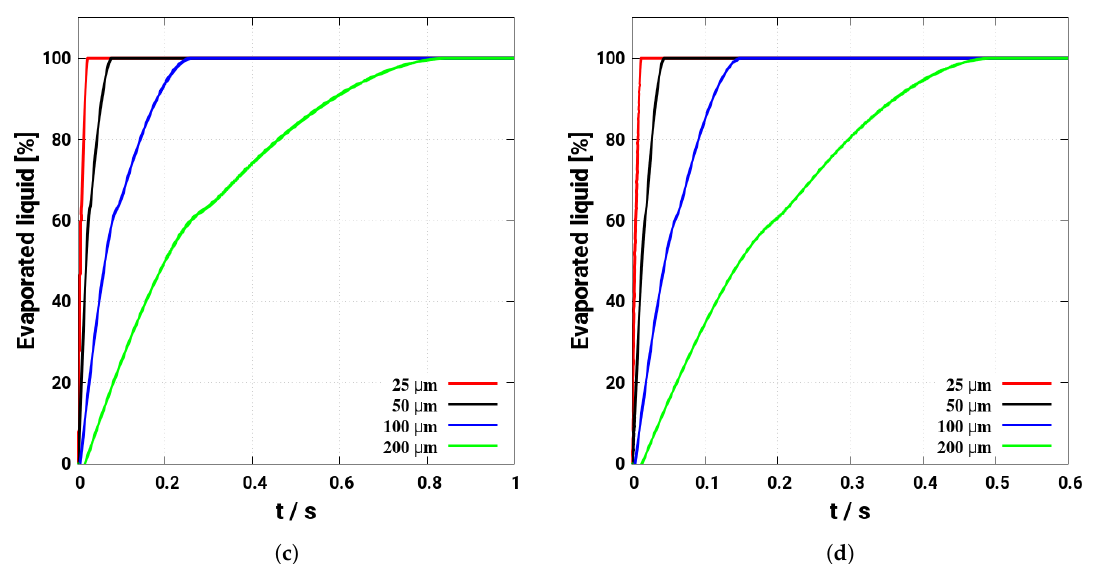
Figure 7. Evaporated droplet mass with respect to various diameter for: ( a ) u rel = 10 m/s, T g = 573 K;